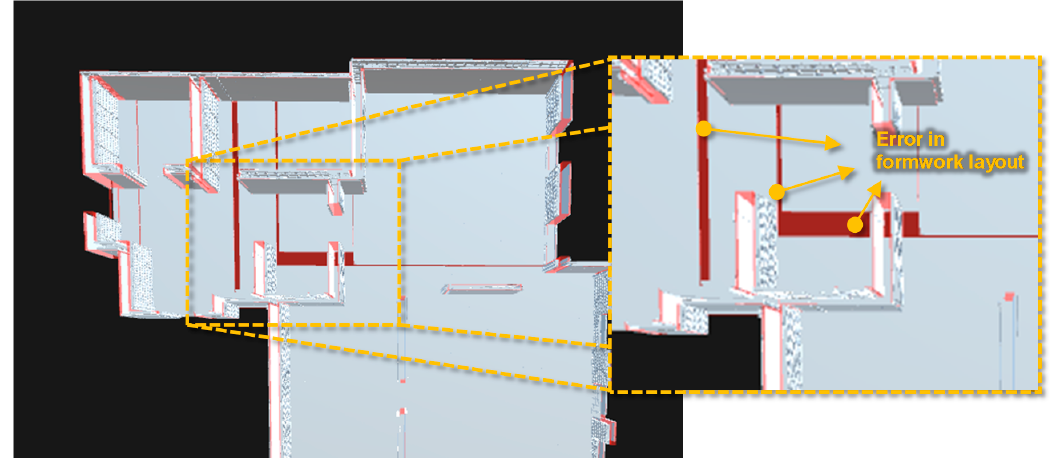
Figure 5. Error in formwork layout.